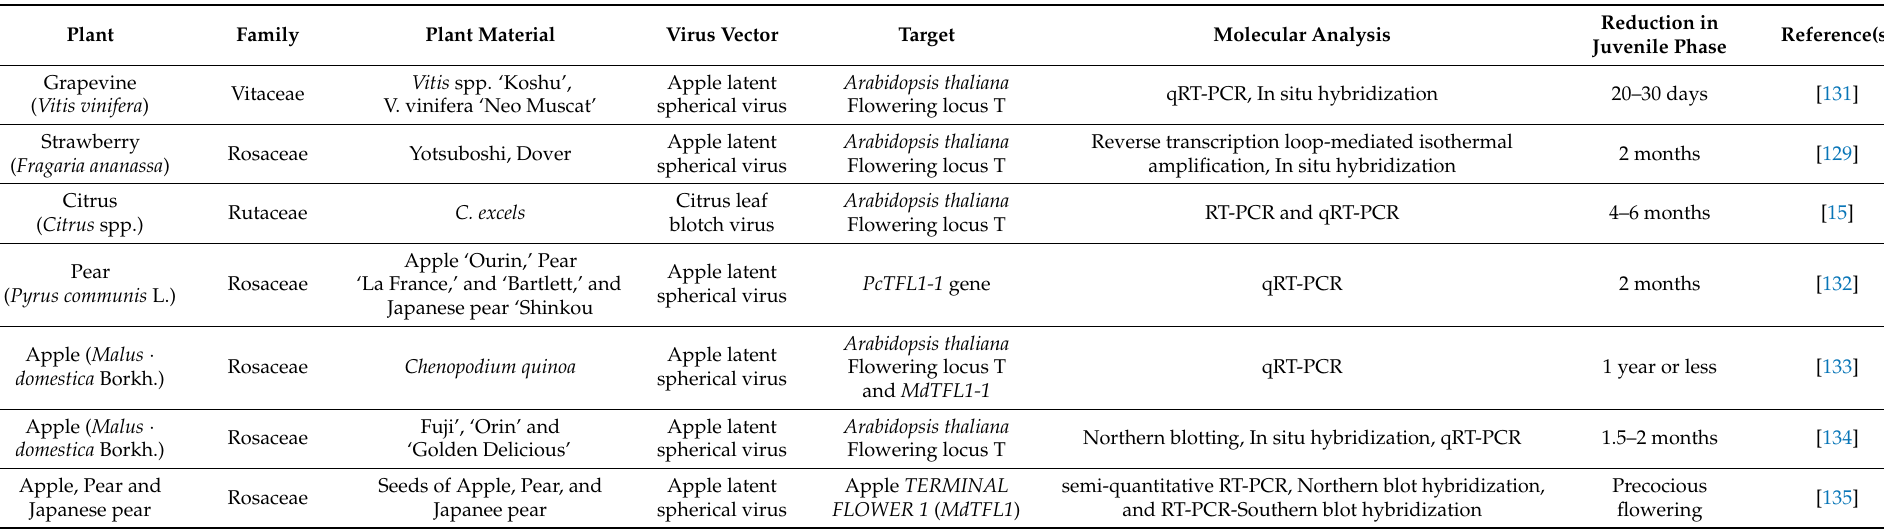
Table 2. Virus-induced flowering in